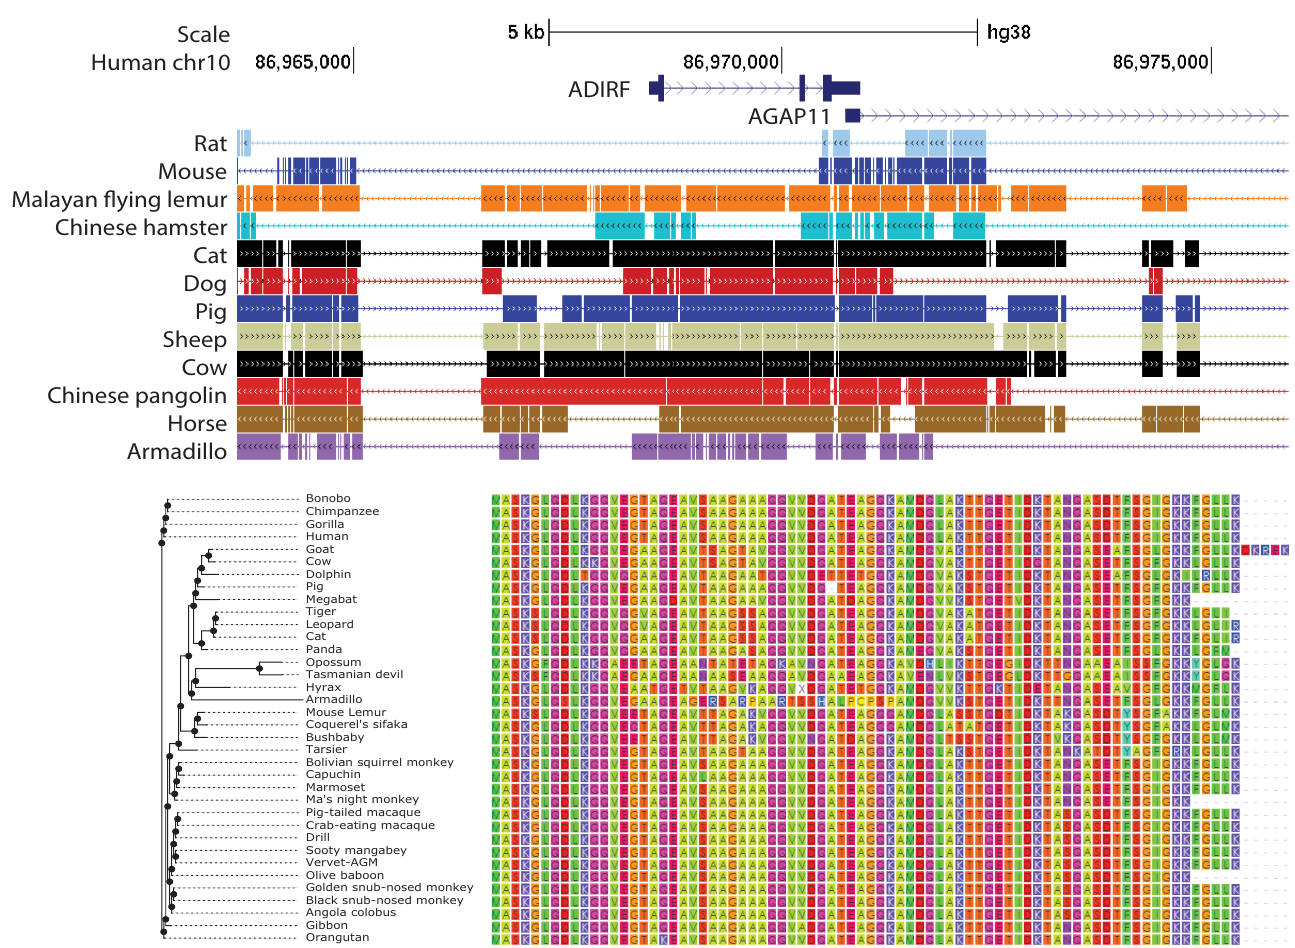
Fig 5. Cross-species molecular analysis of ADIRF. (A) Genomic ADIRF human locus is shown on top, indicating additional genes surrounding this segment of chromosome 10. Below, regions of DNA that are deleted in indicated species (including common experimental models, mouse and rat) are indicated by thin lines. Scale bar represents 5 kb. (B) Predicted amino acid sequences of ADIRF gene products in a variety of species is shown, as predicted by Ensembl. Amino acid classes are color coded to facilitate visual representation of cross-species conservation.